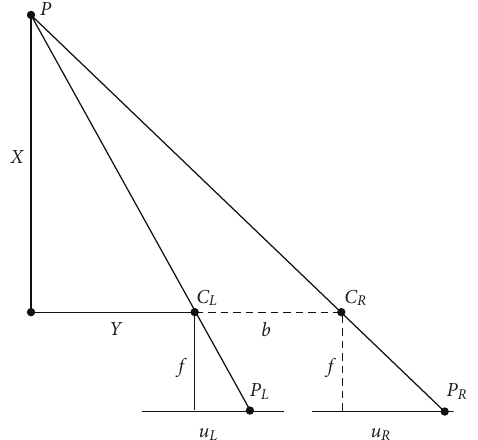
Figure 21: Top down view of two identical parallel cameras with focal length f at distance b to each other.